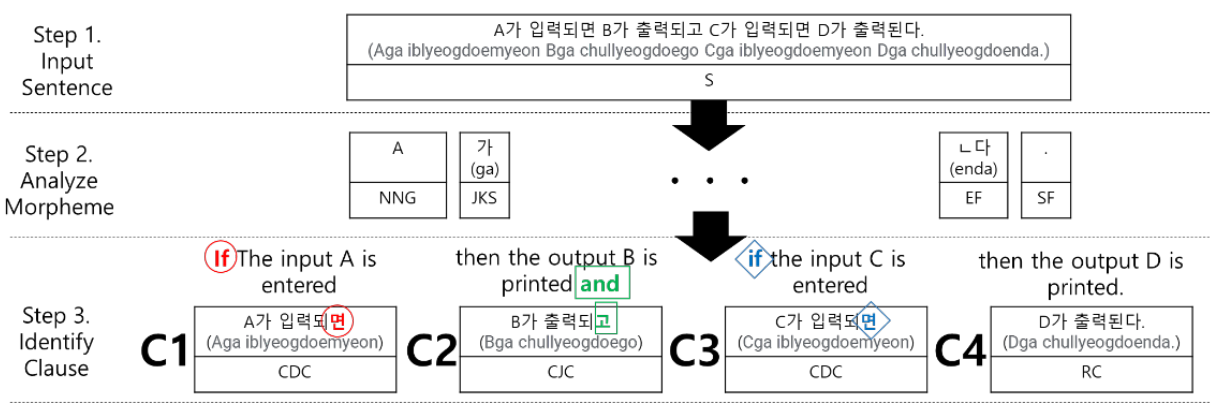
Figure 8. One example of identifying the priority of clauses in a composite sentence.